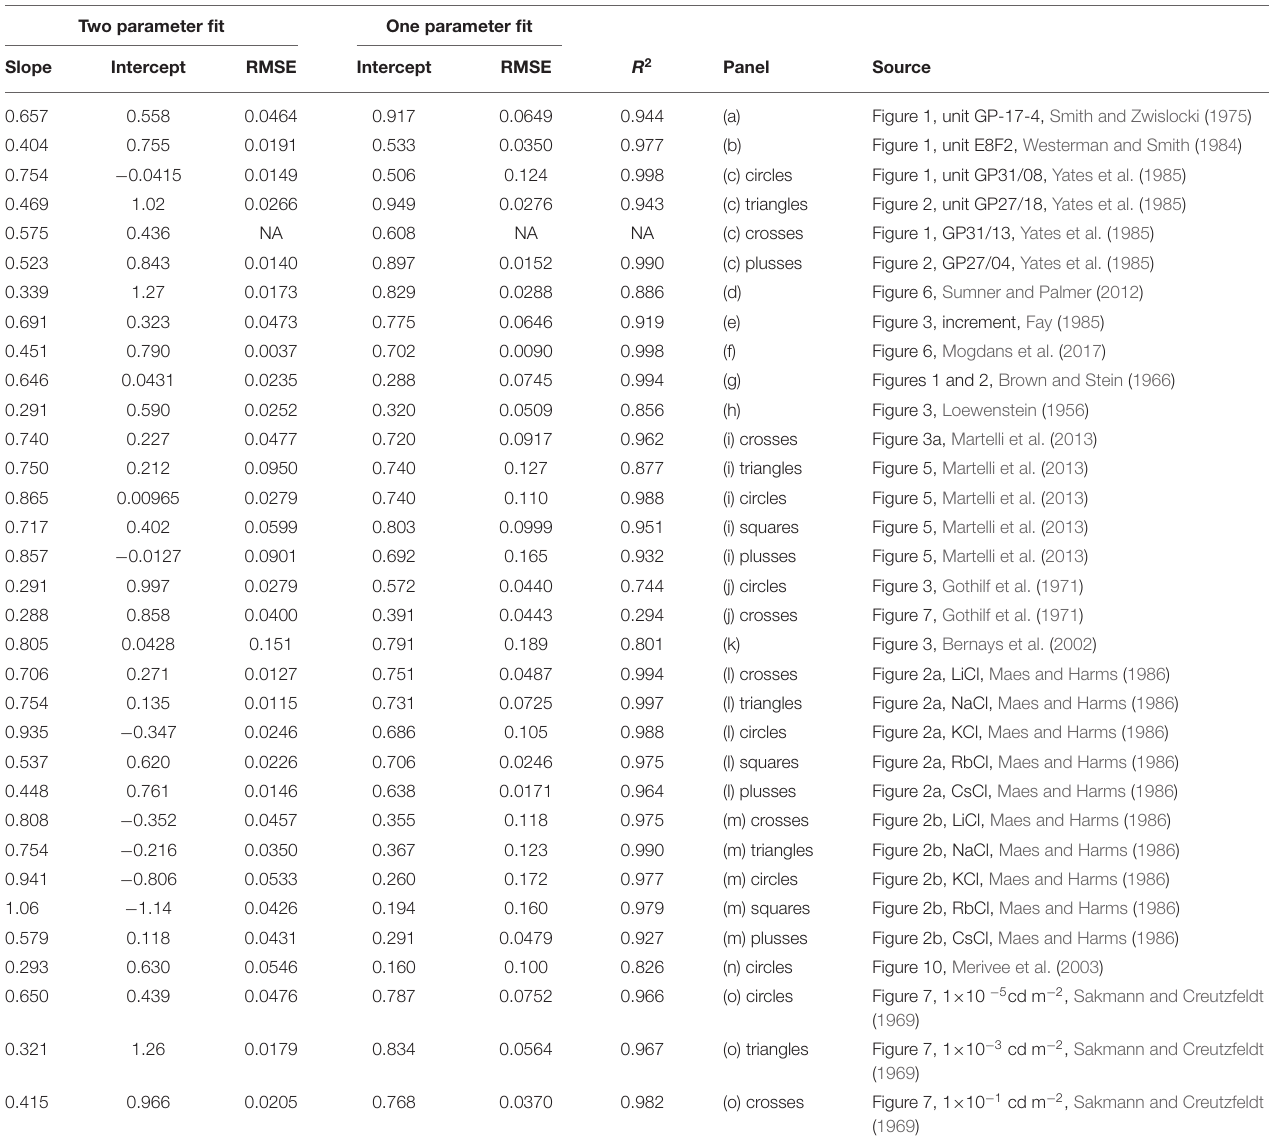
TABLE 3 | Regression analysis of Figure 2 .